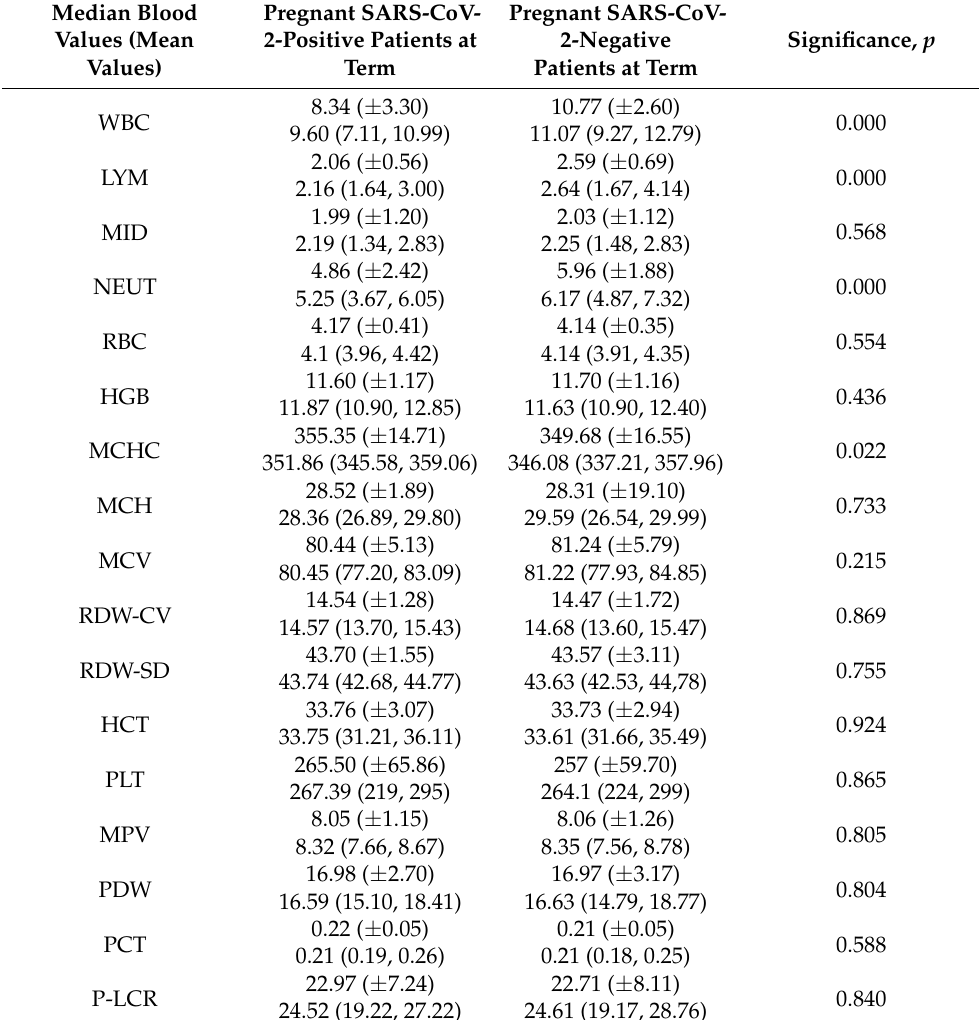
Table 2. Patient characteristics: mean values (and standard deviation) on the upper line, and median values (quartile 1, quartile 2) on the lower line of each value below, in pregnant SARS-Cov-2-positive patients at term compared to pregnant SARS-CoV-2-negative patients at term.